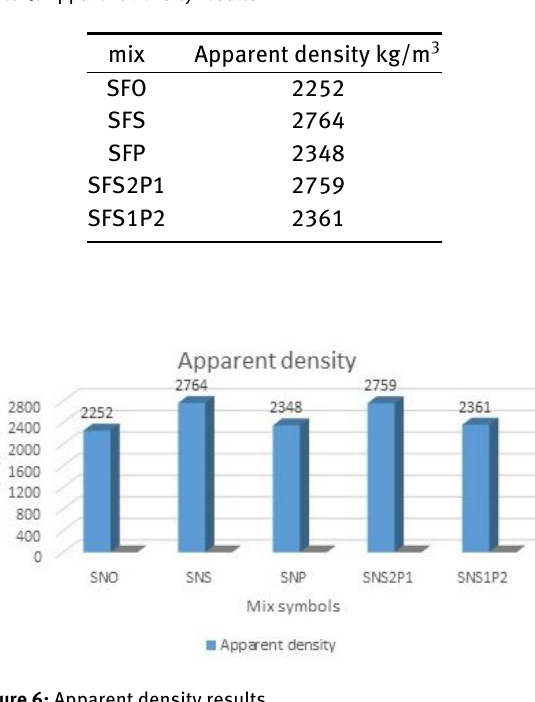
Figure 6: Apparent density